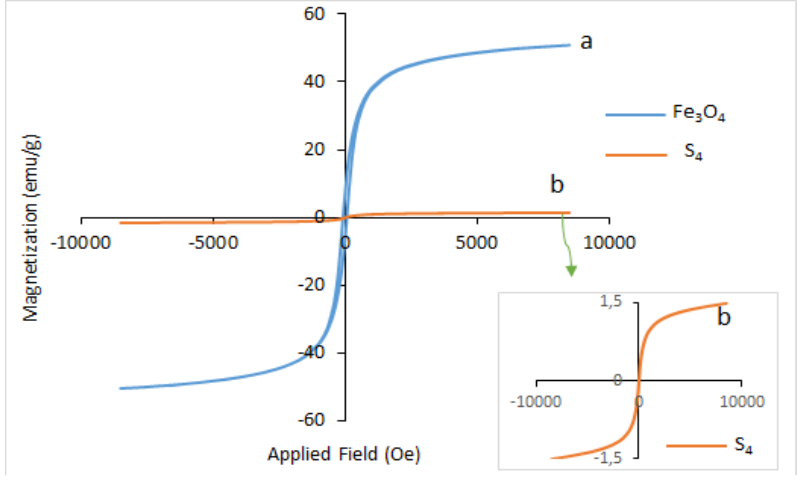
Figure 3. Magnetic hysteresis loops of ( a ) Fe 3 O 4 and ( b ) Fe 3 O 4 /ZnWO 4 /CeVO 4 .